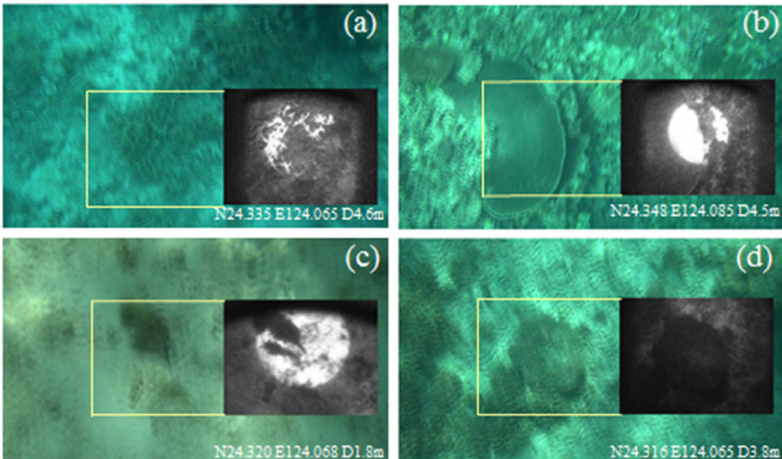
Figure 6. Samples of the fluorescence LIDAR images overlapped with simultaneously recorded video images. ( a ) Branch-type coral; ( b ) table-type coral; ( c ) macro algae on sand; ( d ) dead coral skeleton. Fluorescence images recorded by the ICCD camera are shown in monochrome. Laser footprints are shown as centered circles. White portions inside the laser footprint indicate intensive